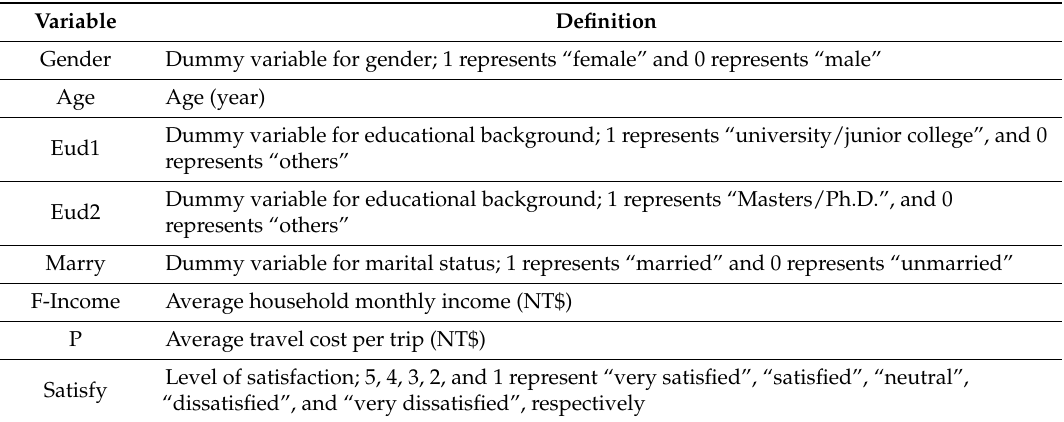
Table 5. Definitions for the independent variables in the empirical